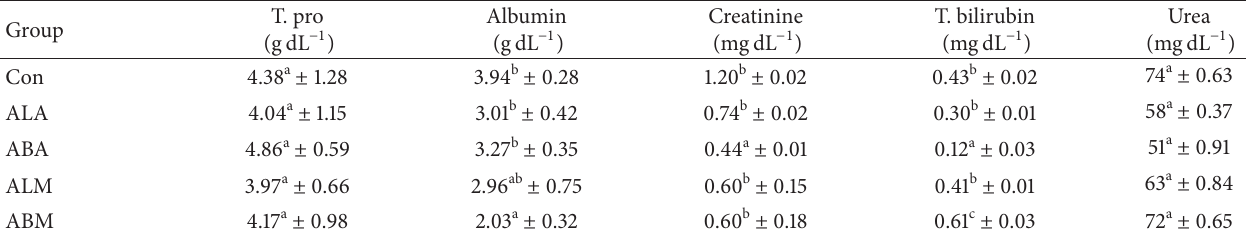
Table 3: Changes in biochemical parameters in serum of control and experimental groups.